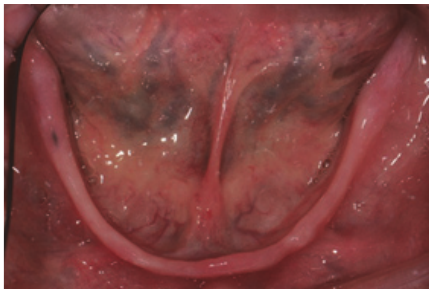
Figure 1: Edentulous mandibular arch with knife-edge ridge.